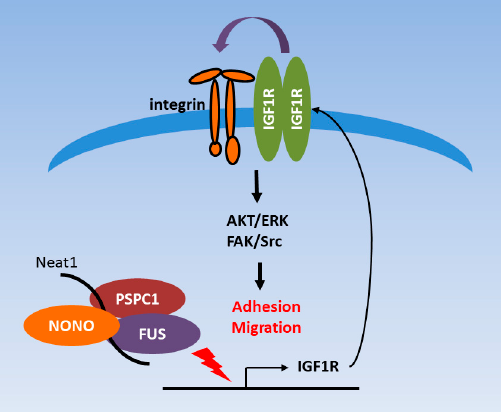
Figure 7. Hypothetical model of PSPC1 / IGF1R axis to facilitate cell adhesion and motility. Supplementary Materials: The following are available online at http: // www.mdpi.com / 2073-4409 / 9 / 6 / 1490 / s1, Figure S1: Expression of IGF1R and integrin in PSPC1-expressing or PSPC1-depleted HCC cells by Western blotting analysis; Figure S2: PSPC1-modulated IGF1R downstream signaling in HCC cells; Table S1: List of constructs, shRNA, siRNA, qRT-PCR primers and 1st antibodies; Table S2: PSPC1-pulldown proteins detected by pulled down, sliced bands after SDS-PAGE separation and LC mass spectroscopy analysis.